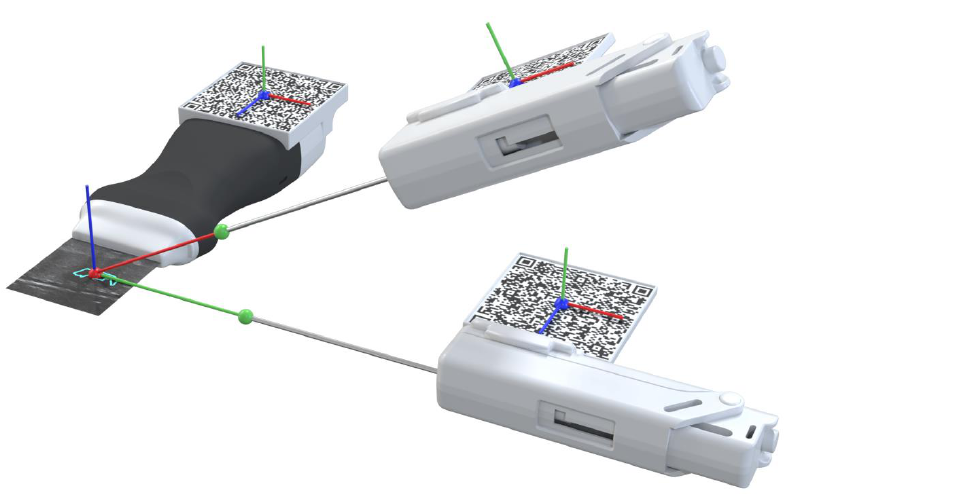
Figure 5. Needle alignment and calculation representation. Alignment is represented by the green line and unalignment is represented by thew red